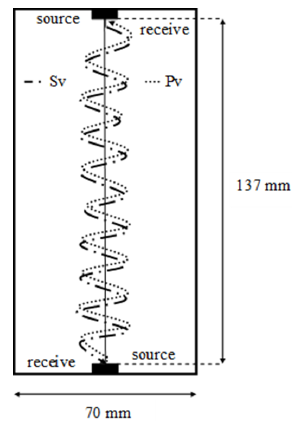
Figure 3. Frontal sample view with bender element (BE) arrangement and an example of the waves’ path.